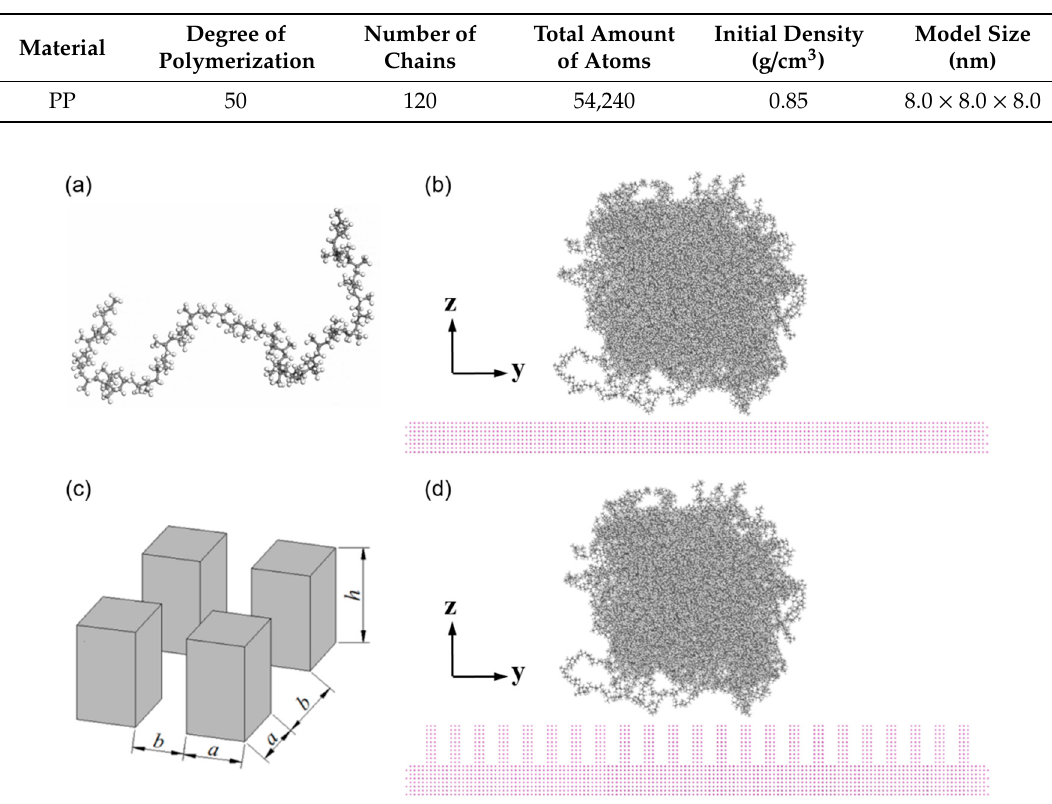
Table 1. Main parameters of polypropylene (PP) atomistic model.